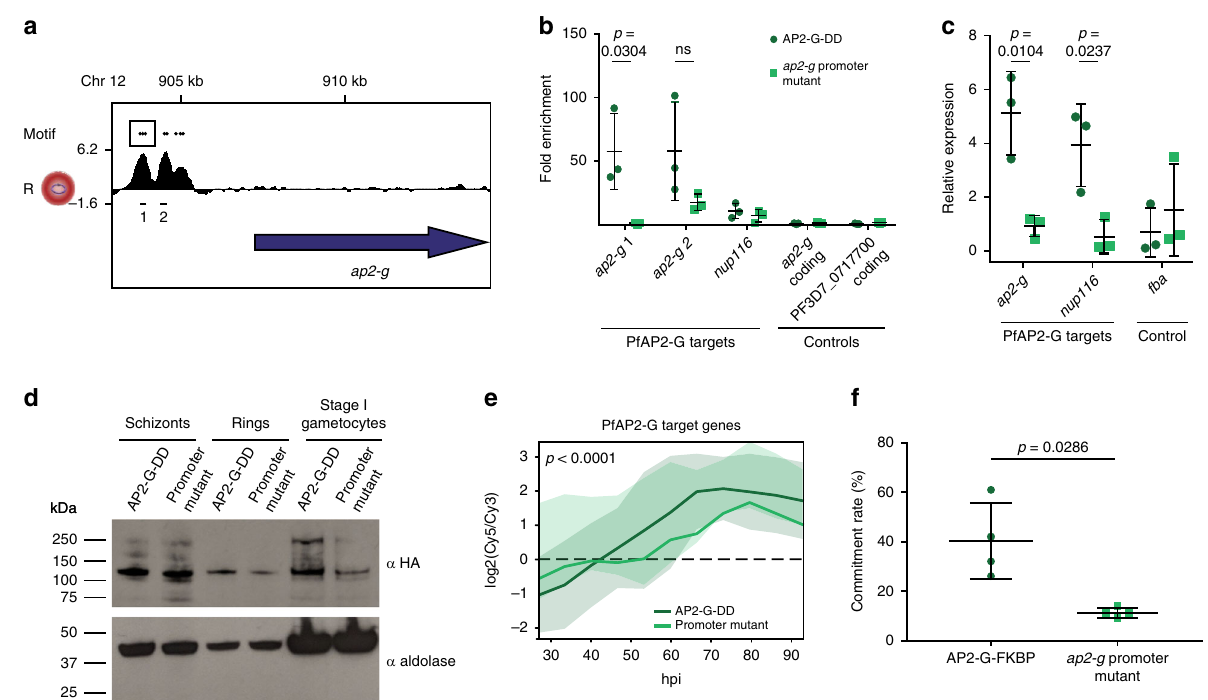
Fig. 4 PfAP2-G regulates its own transcription. a Log2-transformed PfAP2-G ChIP/input ratio tracks for the ap2-g locus in sexual rings. The blue arrow shows the coding sequence. The positions of the PfAP2-G motifs (GTACNC) in the promoter are shown above and the box highlights the three that were mutated. The black lines below indicate the regions of the promoter tested by qPCR in panel c (not to scale). Data are shown for one of the two biological replicates. b ChIP-qPCR performed in ring-stage parasites shows that in the ap2-gpromoter mutant, PfAP2-G is no longer able to bind the region of the promoter containing the mutations. It is still able to bind two other target sites, though at a reduced level compared to its parent. The black bars indicate the mean and standard deviation. n = 3 biologically independent samples. Statistical signi fi cance was tested for using t-tests.ns = not statistically signi fi cant. c qRT-PCR performed in ring-stage parasites shows that mutation of the ap2-gpromoter leads to reduced levels of ap2-gtranscript and that of a target gene. The black bars indicate the mean and standard deviation. n = 3 biologically independent samples. Statistical signi fi cance was tested for using t- tests. d Western blot showing PfAP2-G protein levels in the AP2-G-DD line and the ap2-g promoter mutant parasite line. Aldolase (bottom panel) was used as a loading control. e Plot showing mean temporal expression of the 42 known PfAP2-G targets (from Fig. 1d) in the ap2-g promoter mutant (light green) and the parental line (dark green). The shaded regions show the standard deviation. Differences in expression between the promoter mutant and its parent were tested by two-way ANOVA. f The ap2-gpromoter mutant has a lower commitment rate than its parent. The horizontal bars indicate the mean and standard deviation. n = 4 biologically independent samples. The p-value was calculated using the two-tailed Mann-Whitney U test. Source data for panels b - f are provided as a Source Data fi